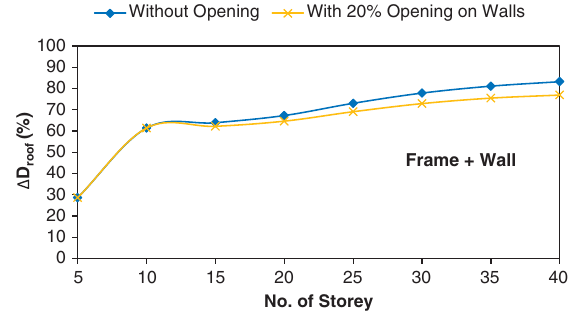
Fig. 4. Roof displacement increment, Δ D roof , in effect of wall